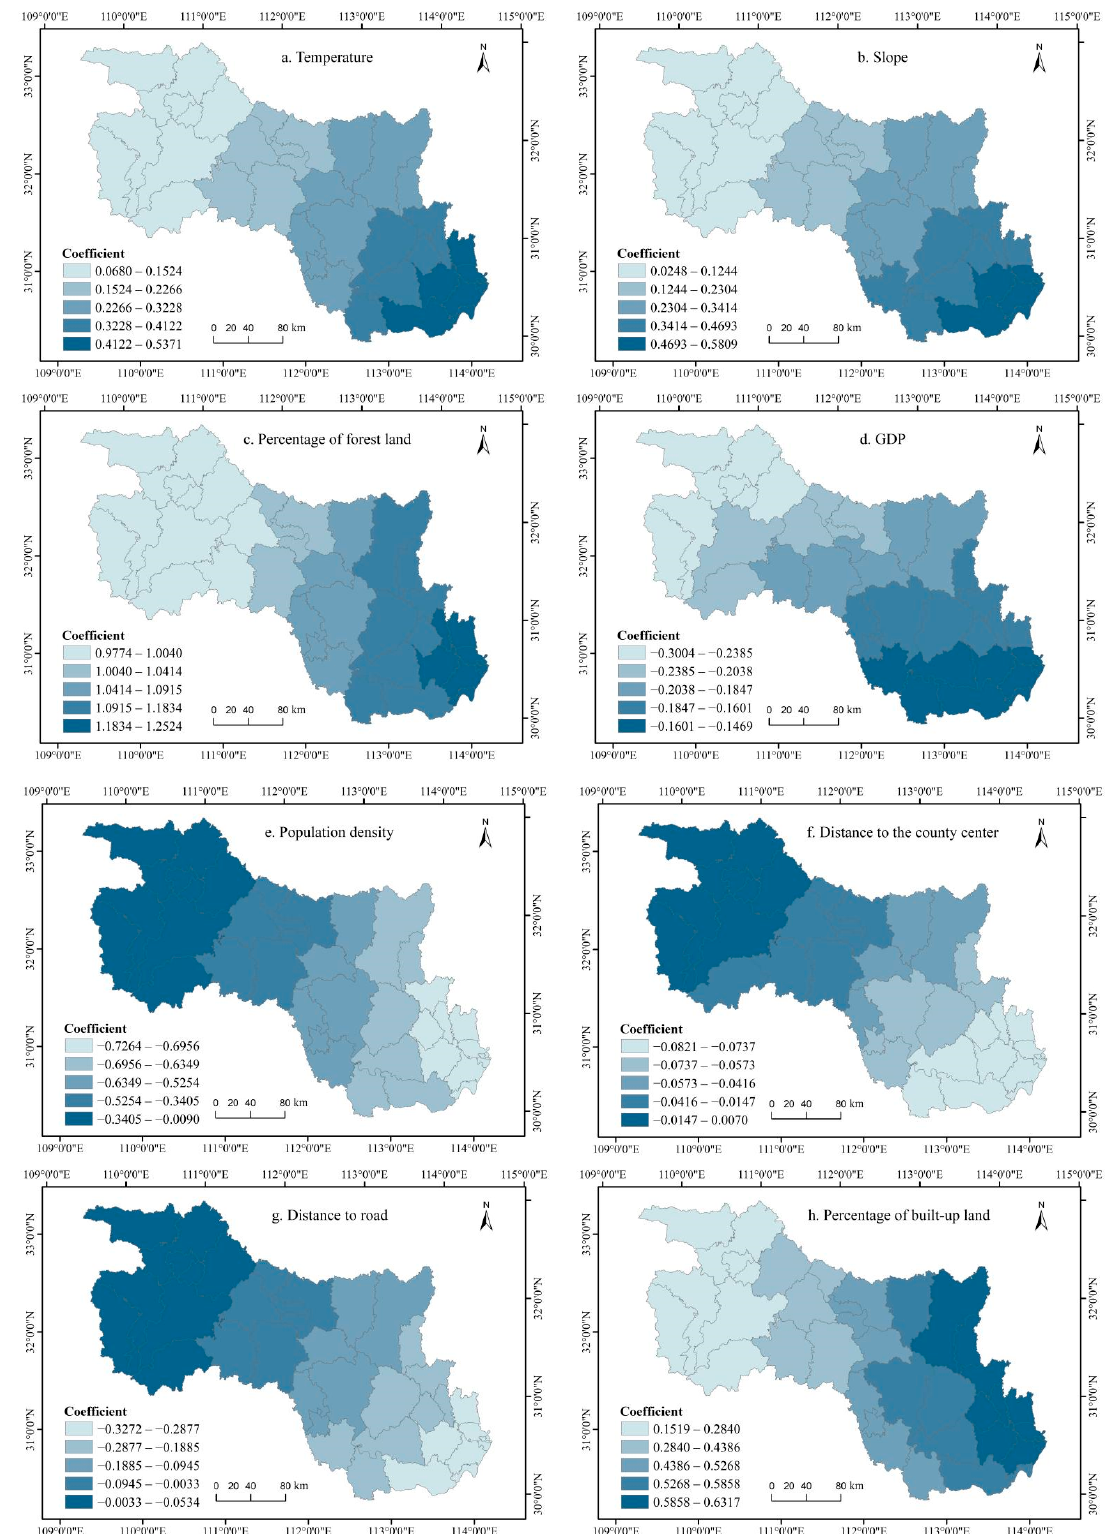
Figure 9. Spatial distribution of regression coefficients in GWR.